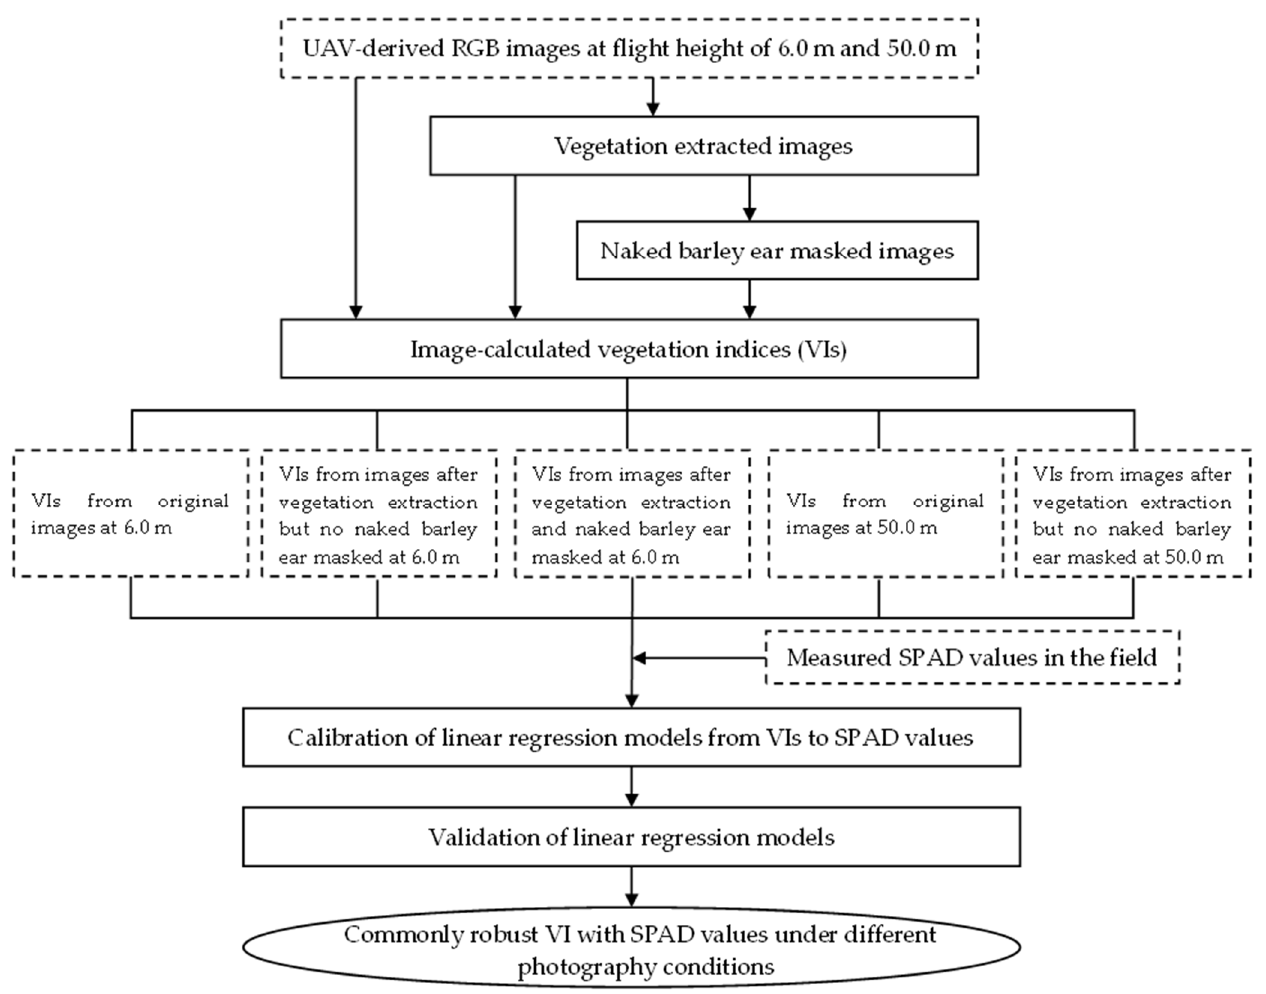
Figure 3. Flowchart of the study.